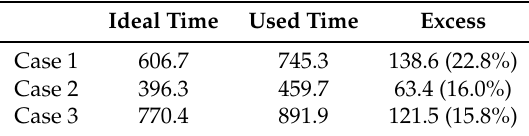
Table 9. Used time vs. ideal case (Units: seconds).